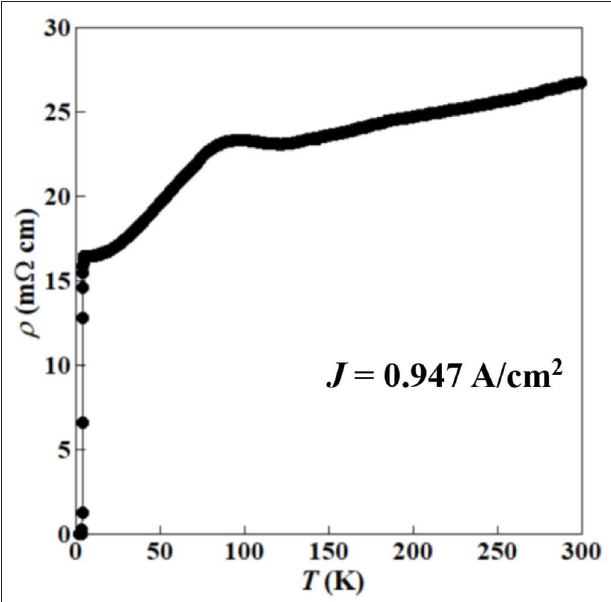
FIGURE 8 | Resistivity–temperature ( ρ - T ) characteristics of (Ce,Pr)OBiS 2 with x = 0.9 single